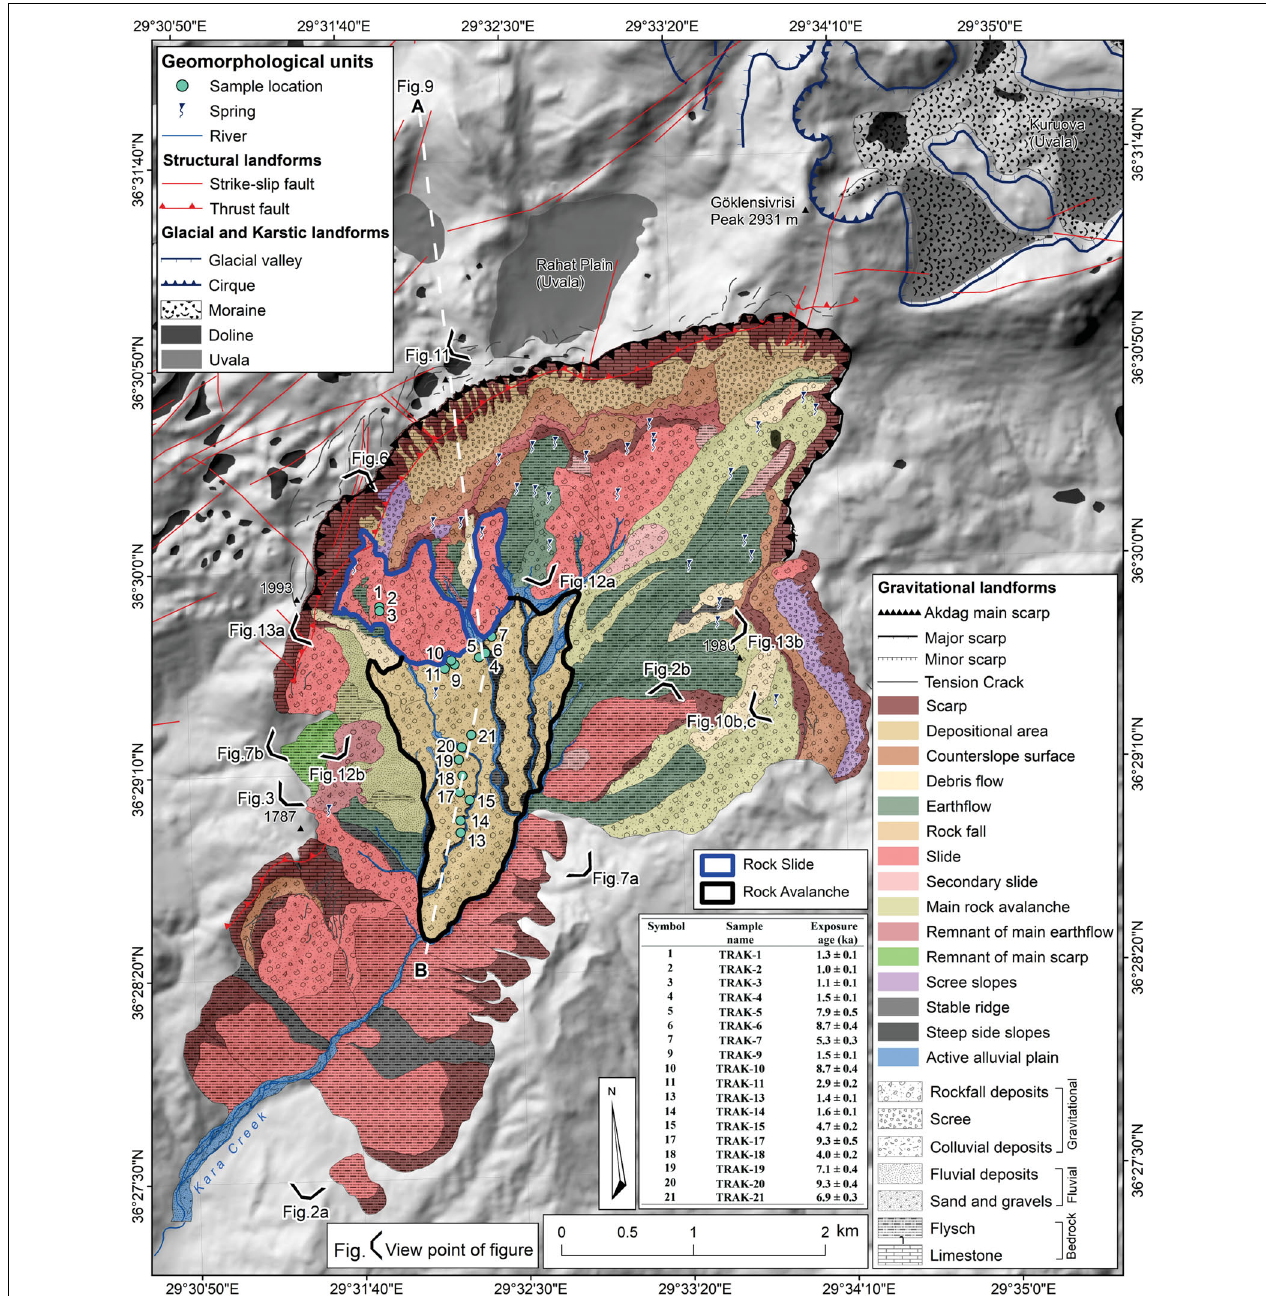
FIGURE 4 | Geological and Geomorphological map of Akdag landslide complex (modified after Görüm et al., 2017), sample locations and 36 Cl cosmogenic exposure ages. Line A to B indicates location of cross section given in Figure 9